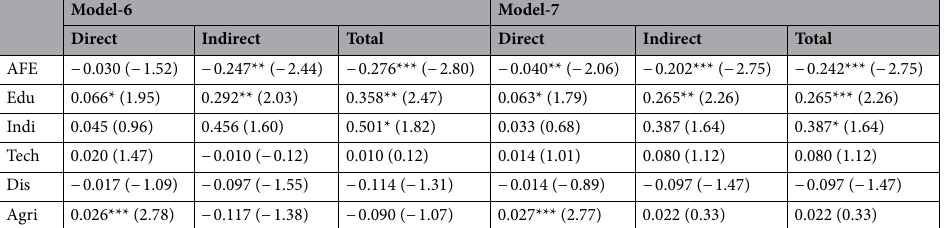
Table 5. Direct, indirect, and total effects under SDM. *, **, *** indicate significance at the 10%, 5% and 1% level. For the estimated coefficients, the standard errors are in